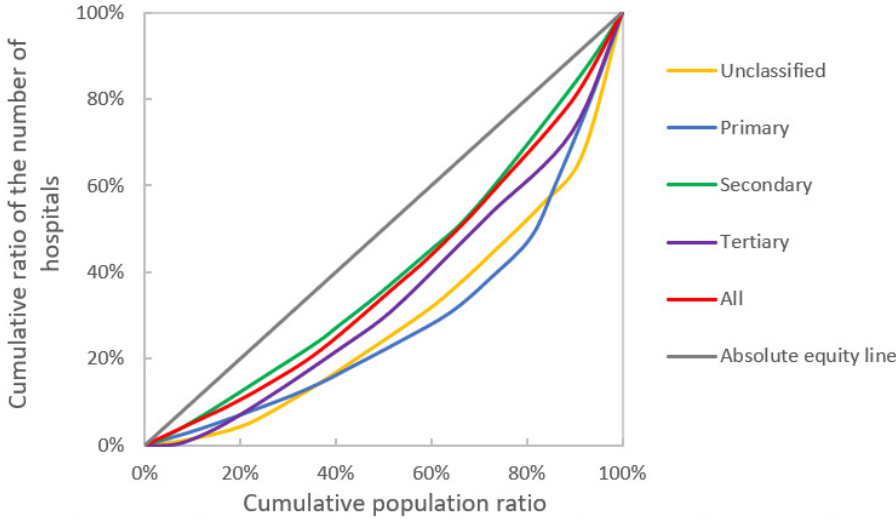
Figure 4. Lorenz curve for different levels of medical institutions by population.